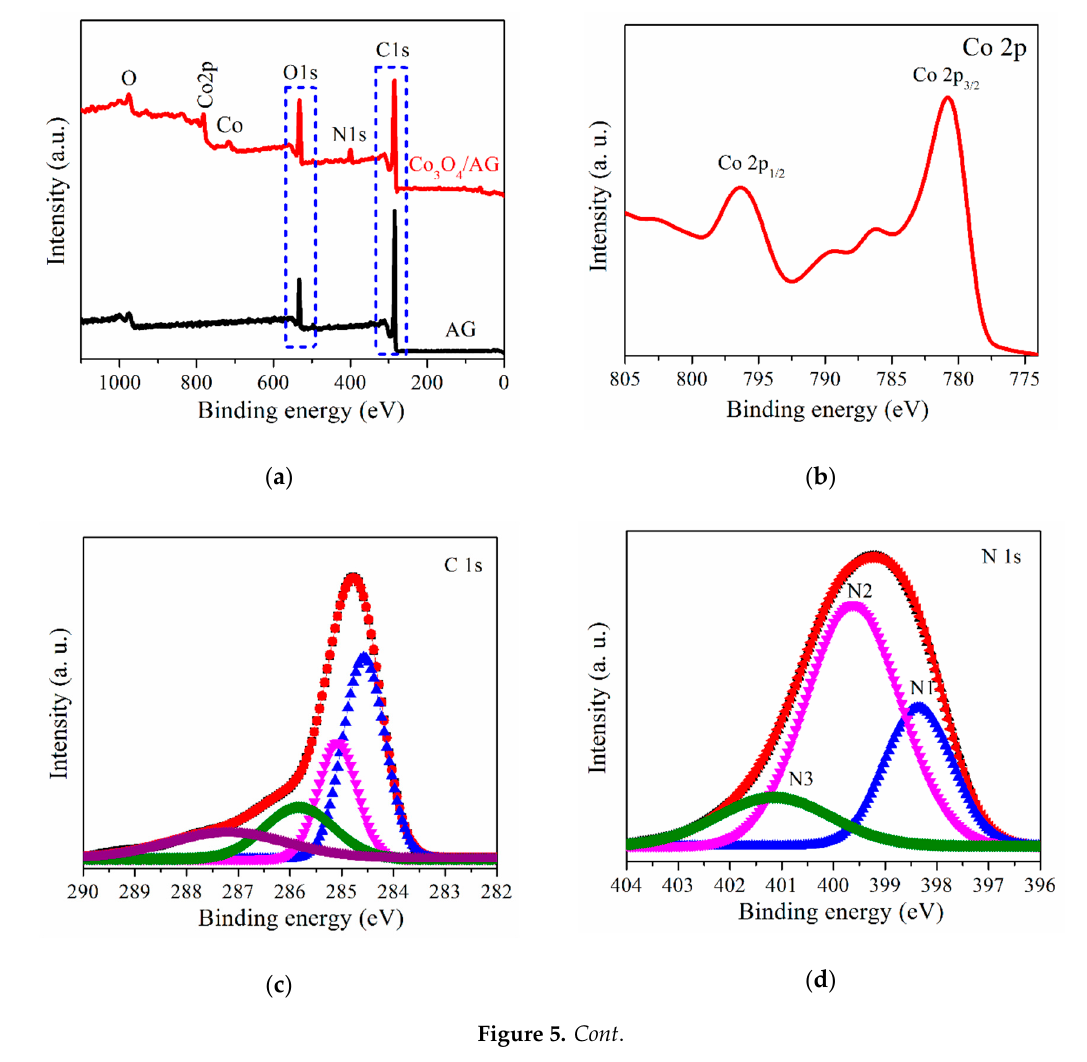
( f ) Figure 5. XPS survey spectra and thermogravimetric (TG) curve of samples: ( a ) Wide scan spectra of AG and the Co 3 O 4 /AG nanocomposite; ( b ), ( c ), ( d ), and ( e ) high-resolution Co 2p, C 1s, N 1s, and O 1s spectra of the Co 3 O 4 /AG nanocomposite; ( f ) TG curve of the Co 3 O 4 /AG nanocomposite. 3.2. Electrochemical Performances